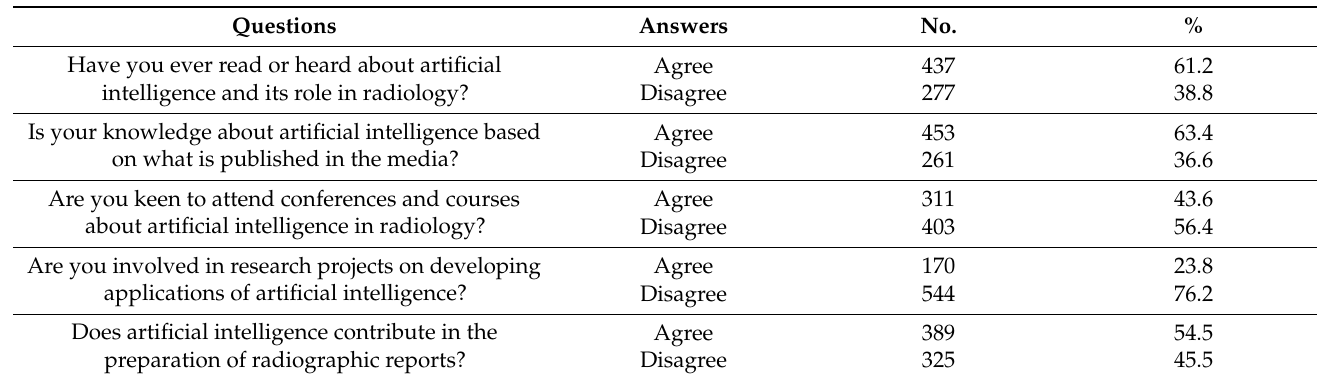
Table 1. Awareness